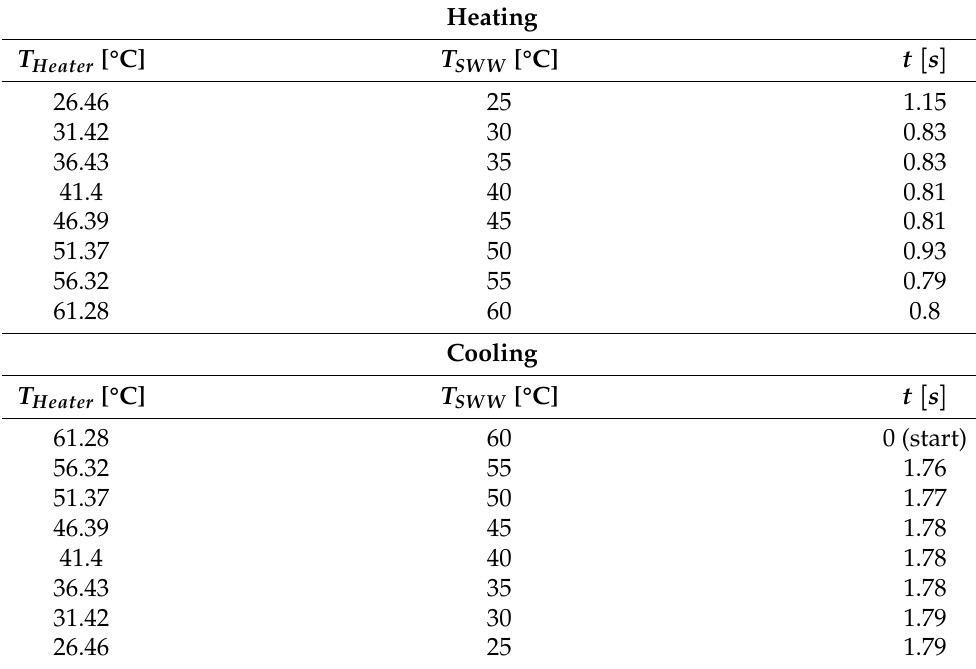
Table 3. Values to be set for the heater to reach the desired temperature of the SWW in the simulation.